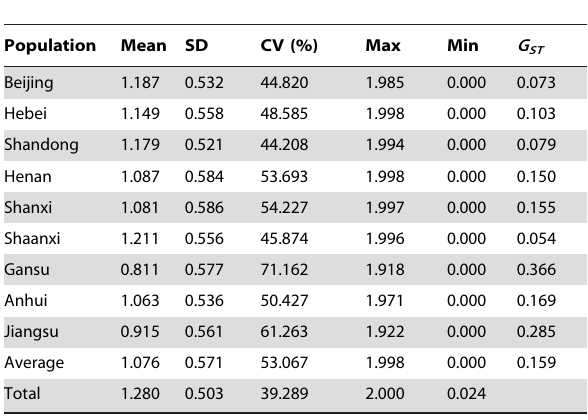
Table 3. The epigenetic diversity a and coefficients of epigenetic differentiation ( G ST ) b assessed by Shannon’s diversity index.